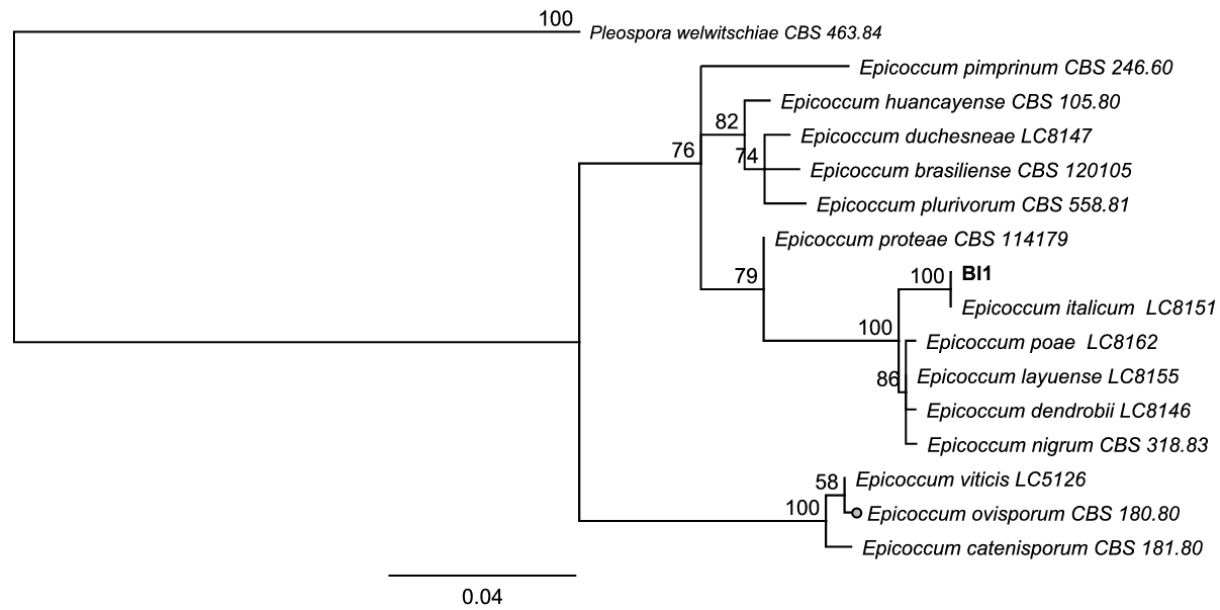
Figure 8. Neighbor-joining tree based on fungal internal transcribed spacer (ITS) sequences of Bl1 (Accession: OK090879), 14 Epicoccum species and Pleospora welwitschiae CBS 463.84 as outgroup. Numbers labeled at each node indicate bootstrap value (percentage) from 1000 replicates. Bar, 0.04 substitutions per nucleotide position.